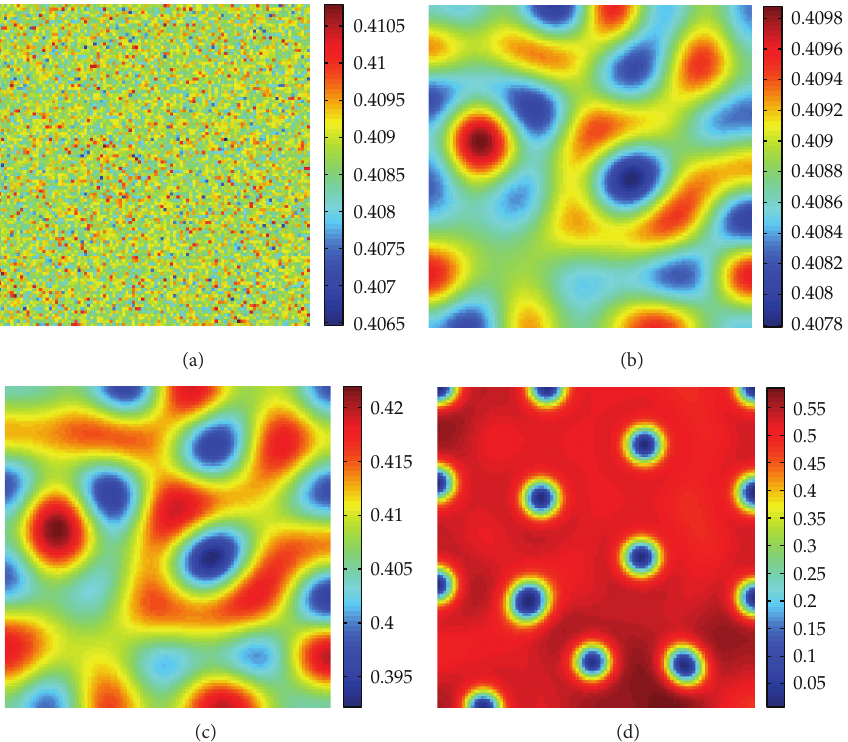
Figure 2: Holes pattern formation for model (5) by taking (𝑏, 𝑠) = (3.6,0.9) . Iterations: (a) 0 ; (b) 1 × 10 5 ; (c) 2 × 10 5 ; (d) 3 × 10 5 .